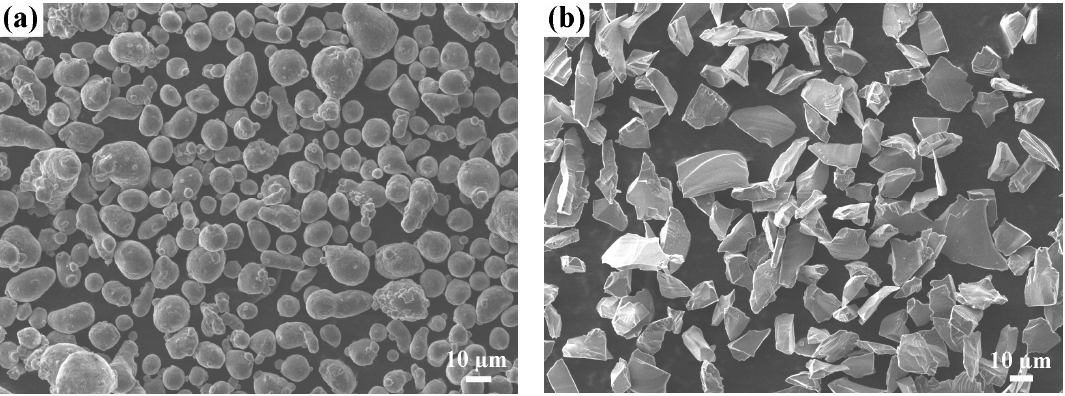
Figure 1. Morphologies of ( a ) 2024Al powders and ( b ) SiC p .